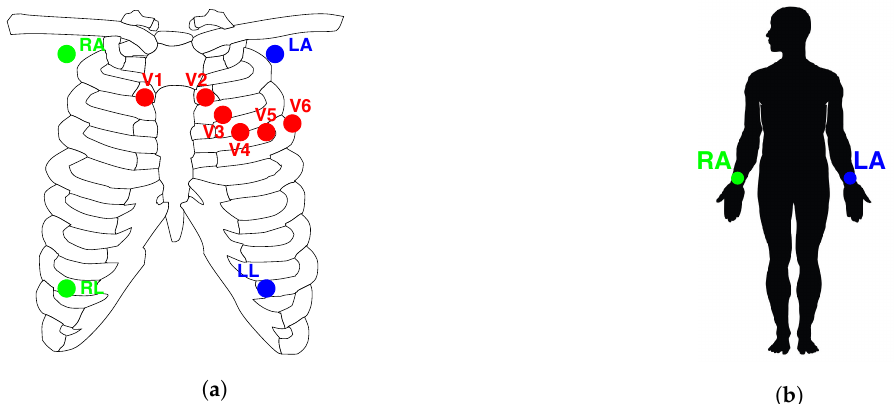
Figure 8. Electrocardiograph (ECG) placement configuration in both devices MAC800 ( a ) and Kardia Mobile ( b